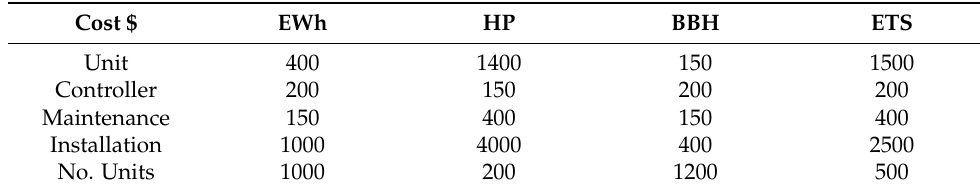
Table 2. Capacities and coefficients for each diesel generator.